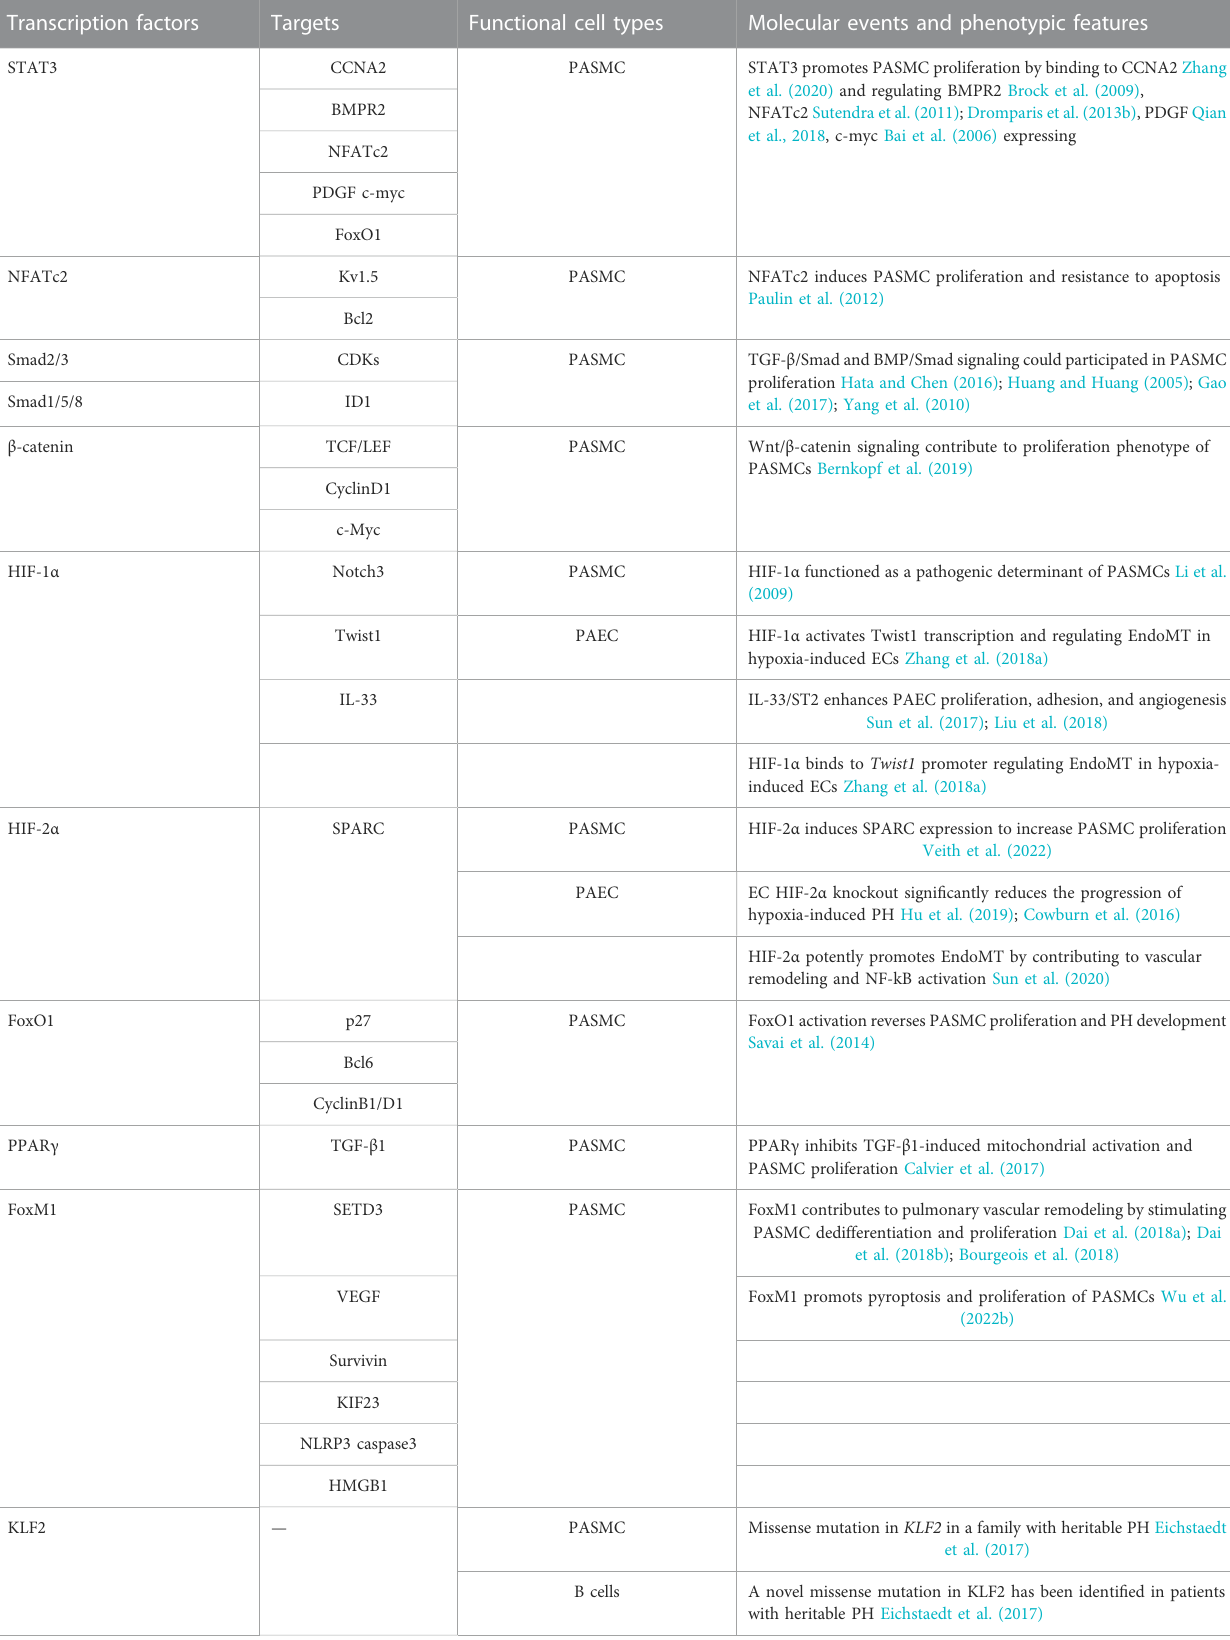
TABLE 1 Summary of transcription factors in pulmonary